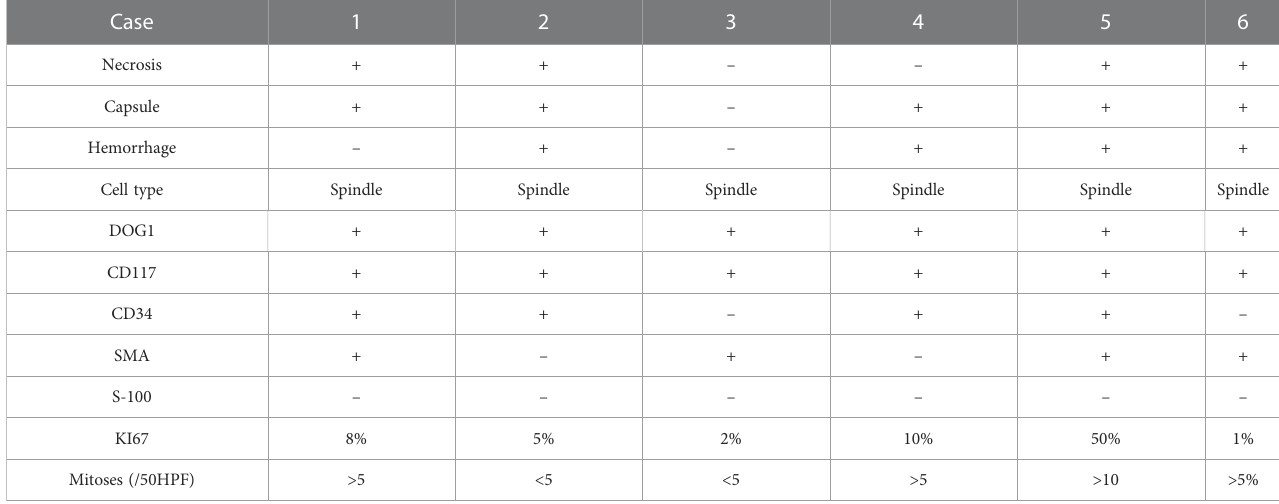
TABLE 2 Pathological features of six patients with retroperitoneal